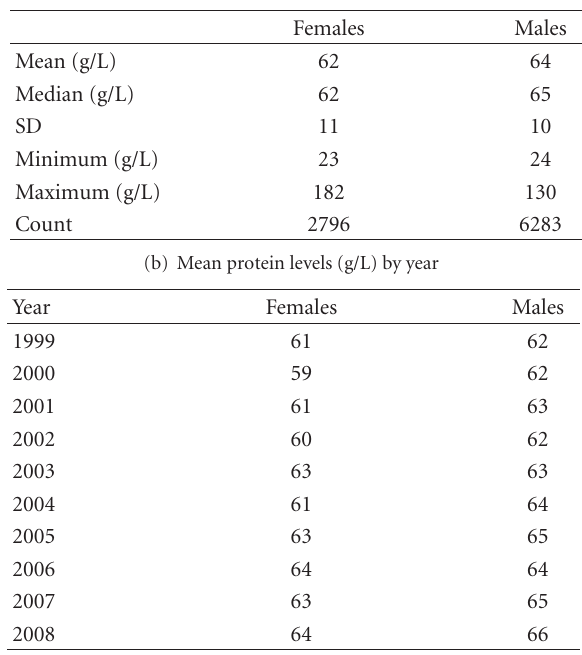
Table 3: Statistics of total protein levels (g/L) in anemic females and